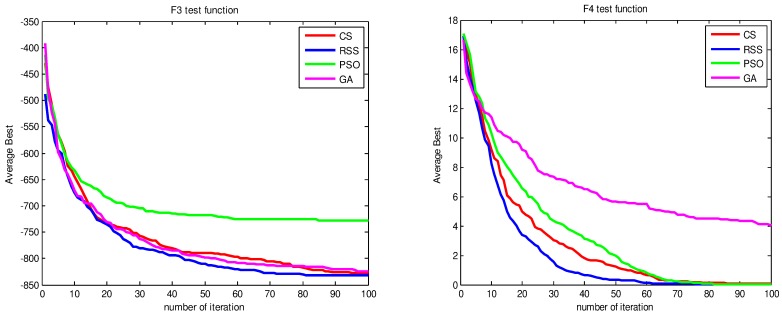
AB convergence of CS, RSS, PSO and GA for minimization of (a) F3 and (b) F4.